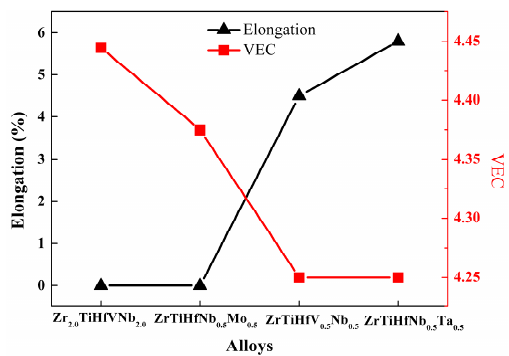
Figure 8. The relationship between the valence electron concentration (VEC) and tensile elongation of different RHEAs.